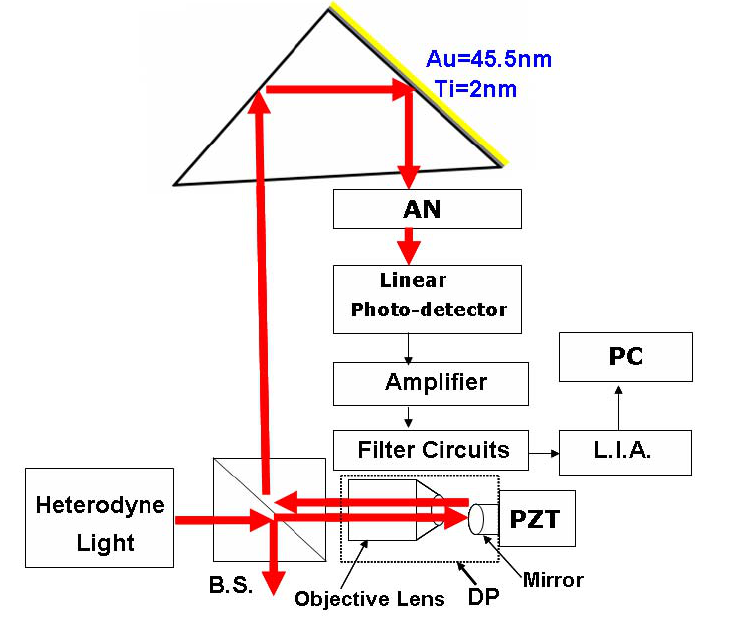
Figure 5. The experimental configuration (AN: analyzer; PZT: piezoelectric transducer, LIA: lock-in amplifier; BS: beam splitters, PC: personal